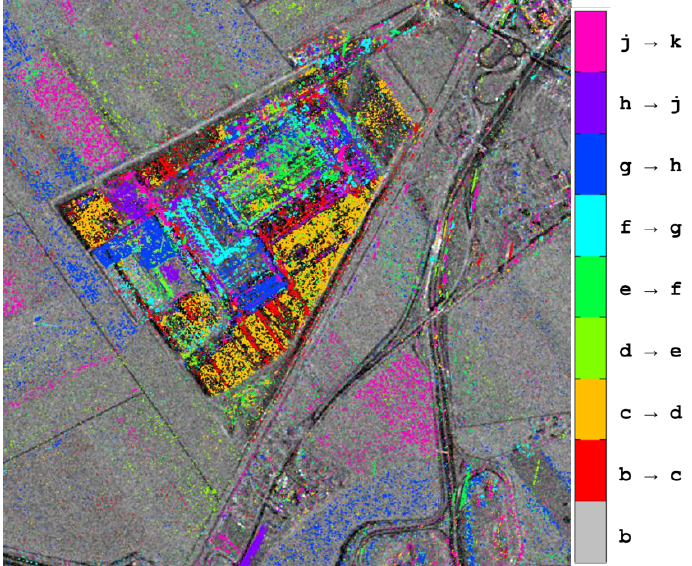
Figure 24. New objects colored according to their time of installation for the factory hall constructed near Ludwigshafen (Germany)—log-ratio thresholding.